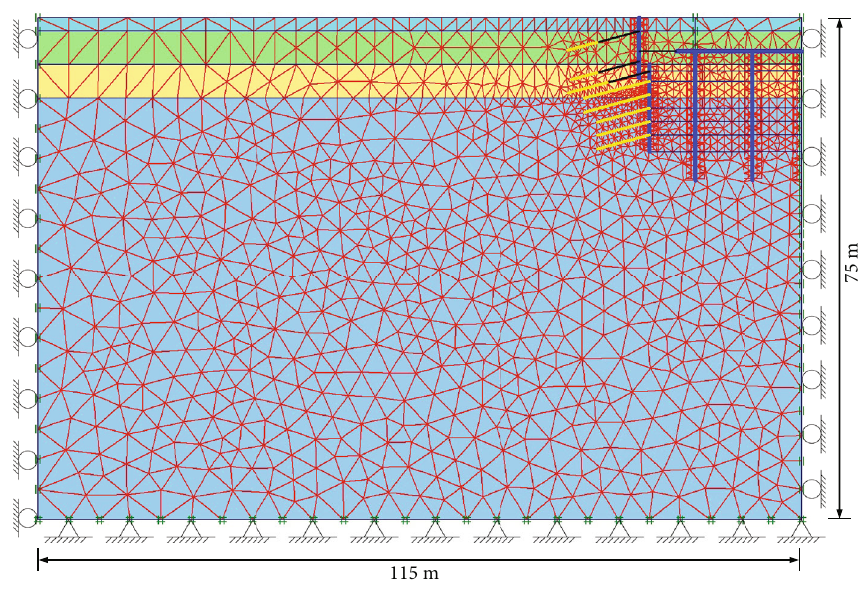
Figure 12: Meshing of the fi nite element analysis model.